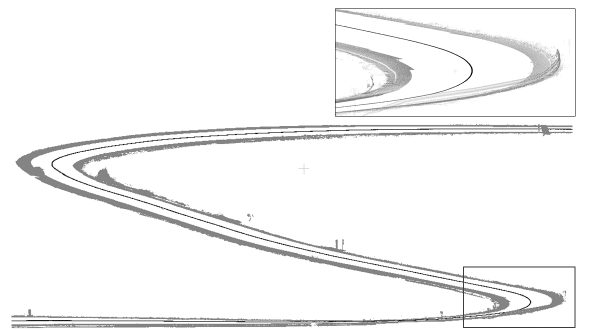
Figure 5. Points classified as barriers or guardrails (in blue), and discarded points (in grey).